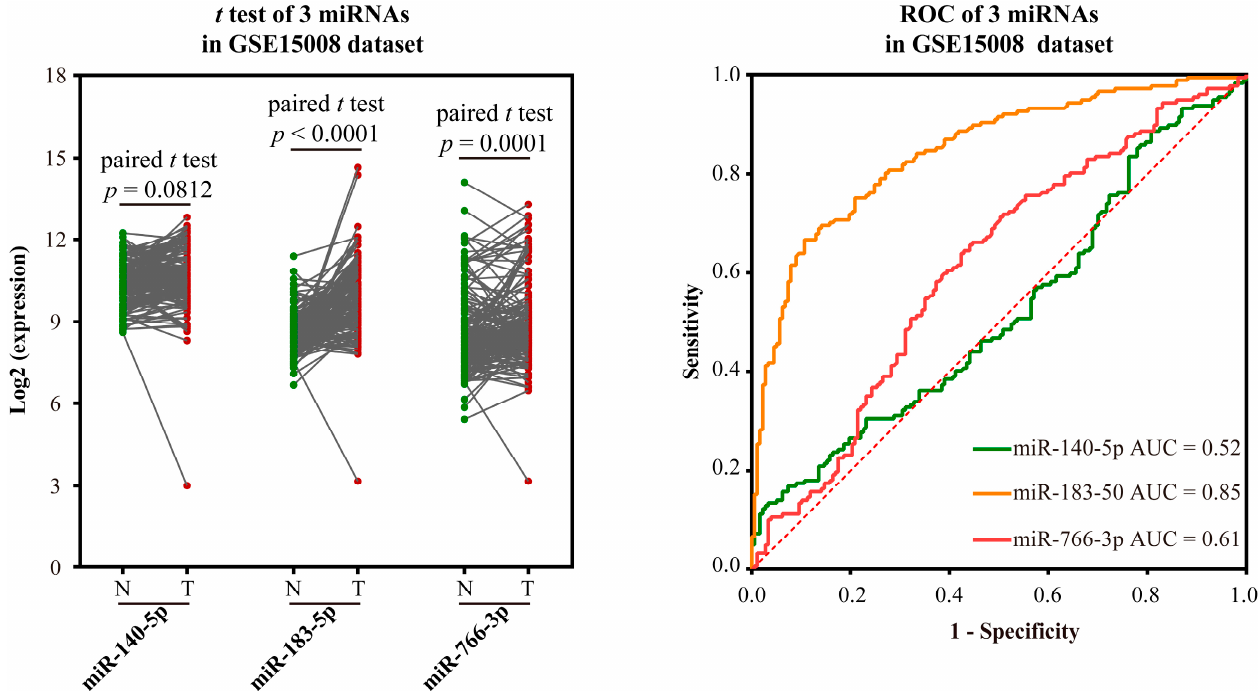
Figure 5. Validation results of 3 miRNA markers in LUSC in GSE15008 dataset. The green dot indicates the normal sample, while the red dot indicates the tumor sample, and the line indicates the paired samples.